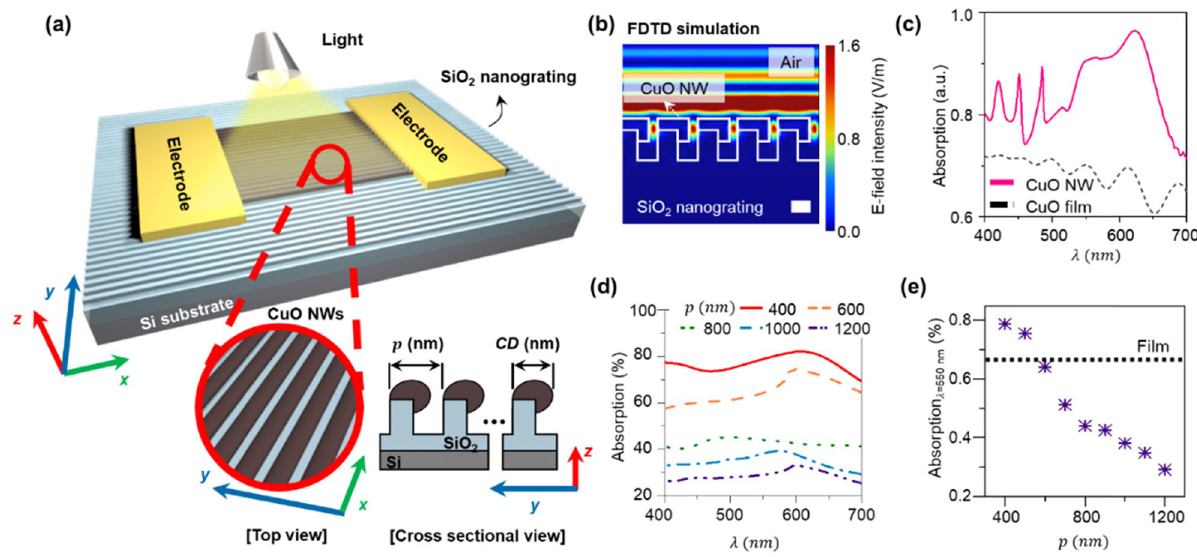
Figure 1. Concept of the proposed high-performance visible light photodetector. ( a ) 3-D schematic of the proposed device. The device is composed of the perfectly aligned CuO nanowire array (see [Top view]) on the SiO 2 nanograting substrate (see [Cross sectional view]). ( b ) FDTD simulation result of the proposed device (scale bar = 200 nm). ( c ) Calculated absorption of the 400 nm-pitch ( p ) of CuO nanowire (NW) array on SiO 2 nanograting substrate (pink solid line). Black dashed line indicates the absorption of CuO thin film ( thickness = 122 nm). Calculated absorption varying pitch of CuO NWs with same dimension on SiO 2 nanograting from 400 to 1200 nm ( width = 314 nm, thickness = 114 nm): ( d ) visible light range ( λ = 400–700 nm) ( e ) λ = 550